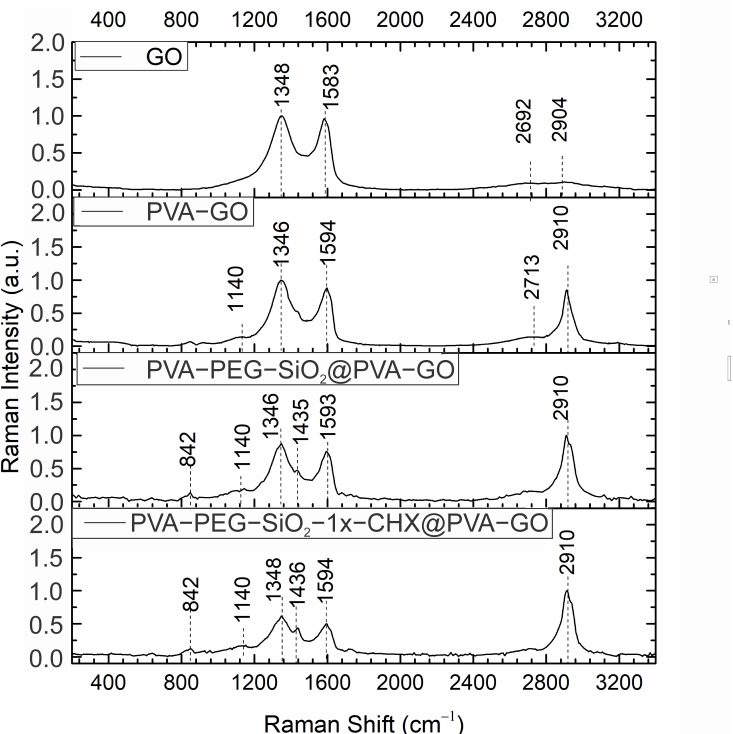
Figure 3. Raman spectra of PVA-based and GO-derived fiber mats in the range of 200–3400 cm − 1 . Defining the GO structure, the ratio of I D /I G = 1.03 indicates the high reduction de- gree of GO. Reduced graphene oxide (rGO) differs due to its higher conductivity and sp 2 cluster organization, which is important to consider for the electrospinning process